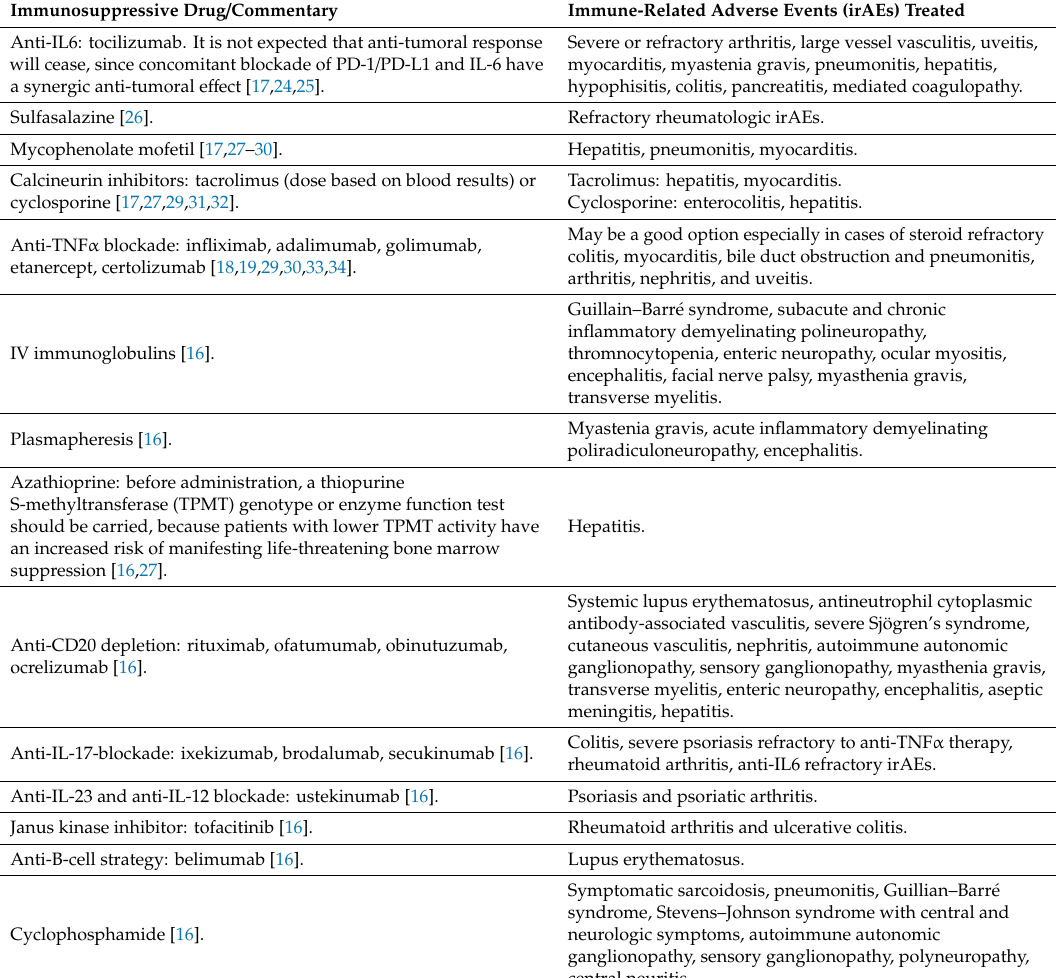
Table 5. Therapeutic options of immunosuppressant nature besides steroids for irAEs